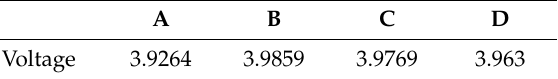
Table 9. The initial cell voltages of four batteries (voltage unit: V).